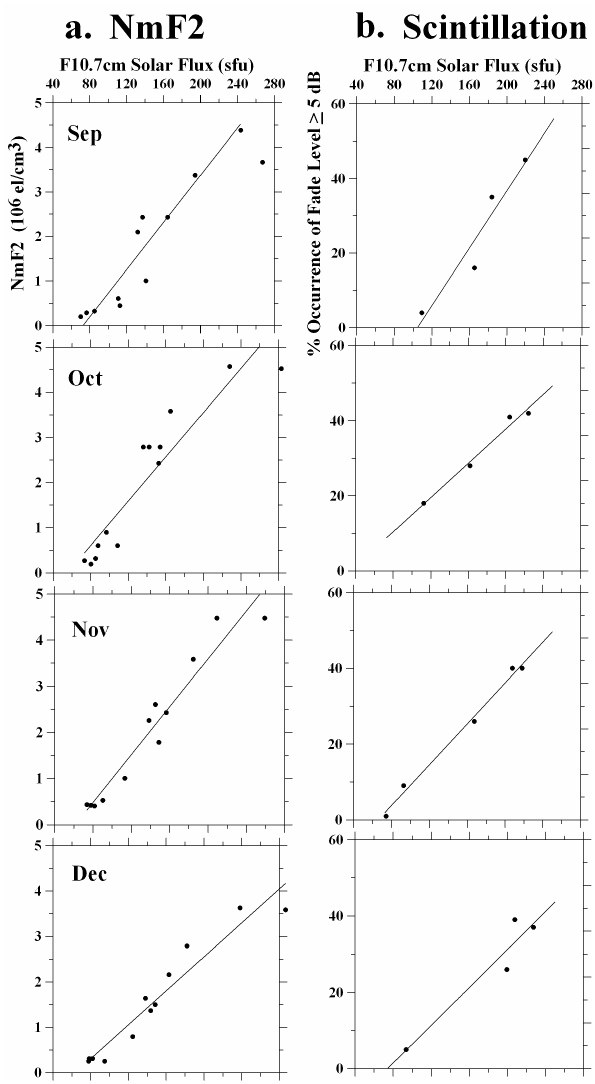
Fig. 6. S4 and Nm F2 dependence on solar flux from 1980 (solar maximum) through 1985 (solar minimum) from September to De- cember. (a) Nm F2 from Taipei (Whalen, 2004). (b) 1.5GHz scin- tillation recorded at Ascension Island. % occurrence of > 5dB is approximately % occurrence of S4 >